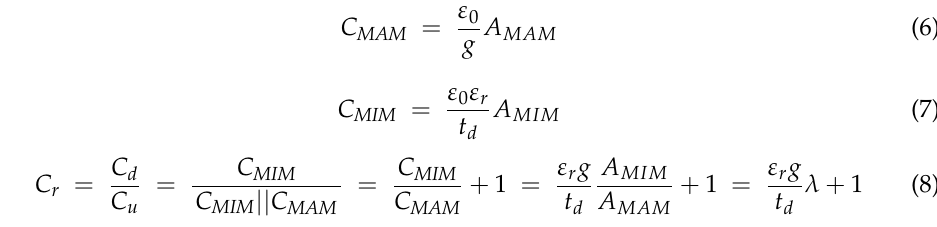
Figure 5. Circuit topology of the proposed MEMS switch with MIM capacitors.